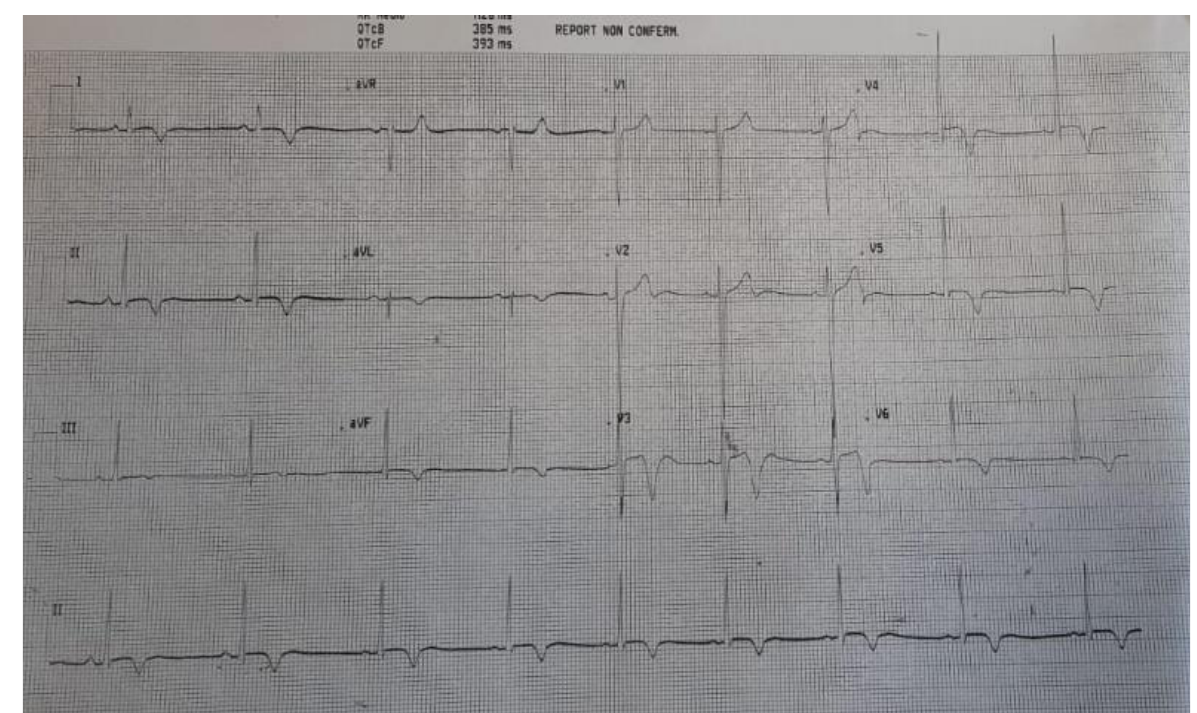
Figure 3. ECG at discharge. Diffuse ST elevation resolved and was replaced by deep negative T waves.